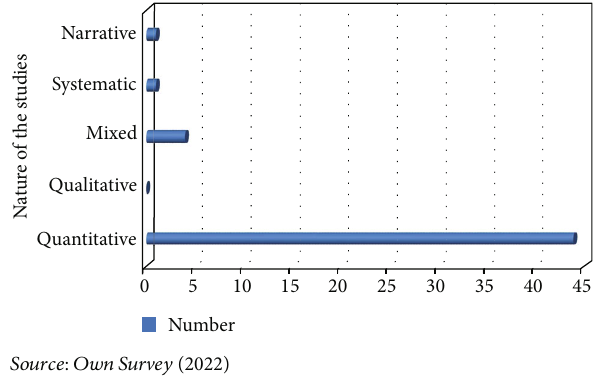
Figure 2: Nature of the